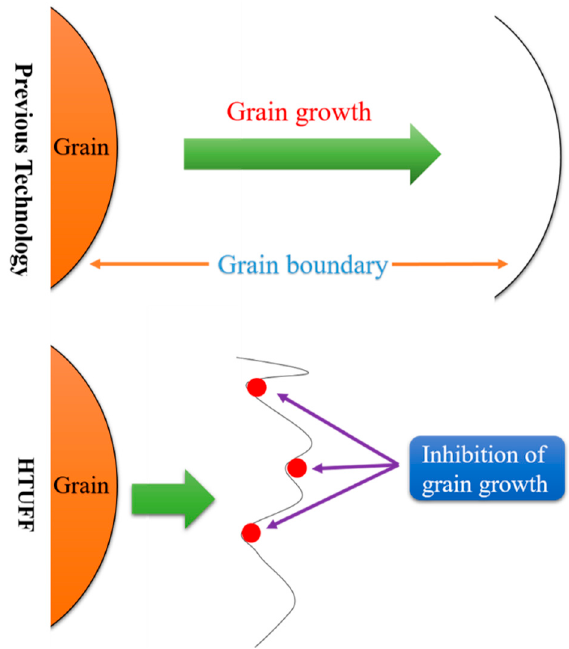
Figure 3. Characteristics of HTUFE [27].